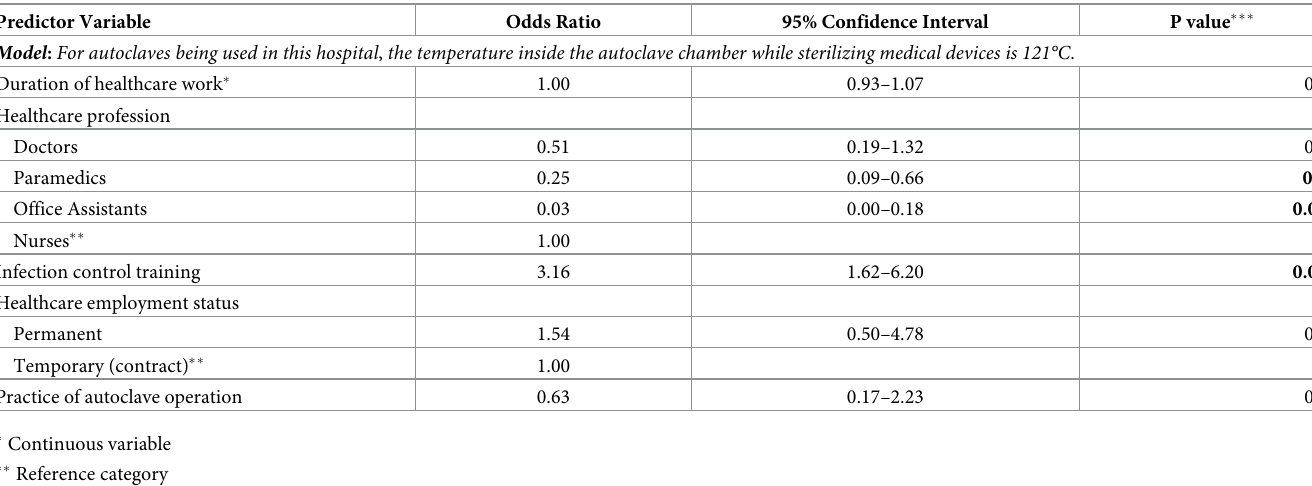
Table 5. Complex samples—logistic regression model for knowledge of recommended temperature.